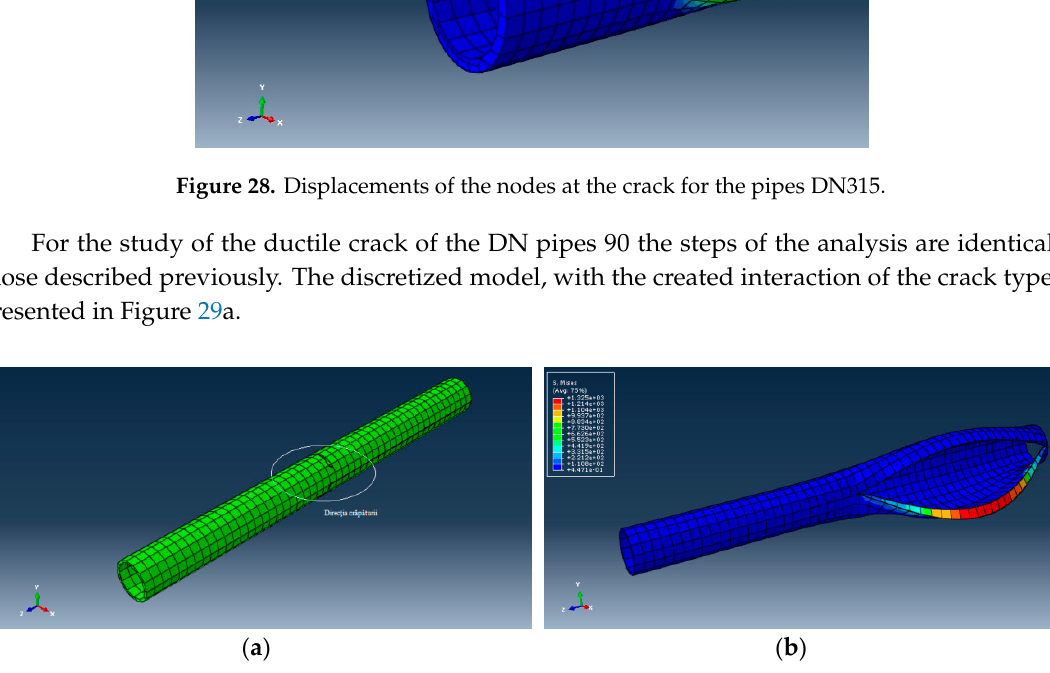
Figure 29. ( a ) Crack analysis model of pipe DN 90 and ( b ) Broken model of pipes DN 90.